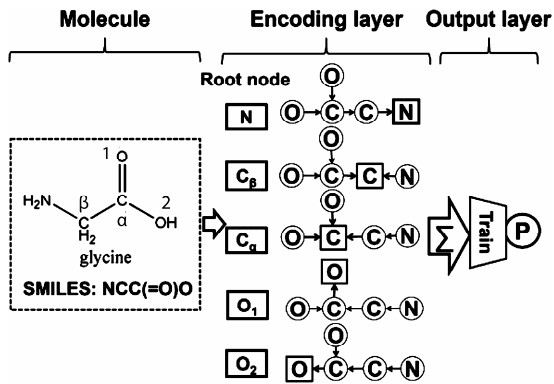
Figure 8. Schematic diagram of Youjun Xu et al. network encoding glycine, first using primary canonical SMILES strucuture. Then, each of the atoms in the SMILES structure is sequentially defined as a root node. Finally, information for all other atoms is transferred along the shortest possible paths, in which case is obtained following the narrows [67].